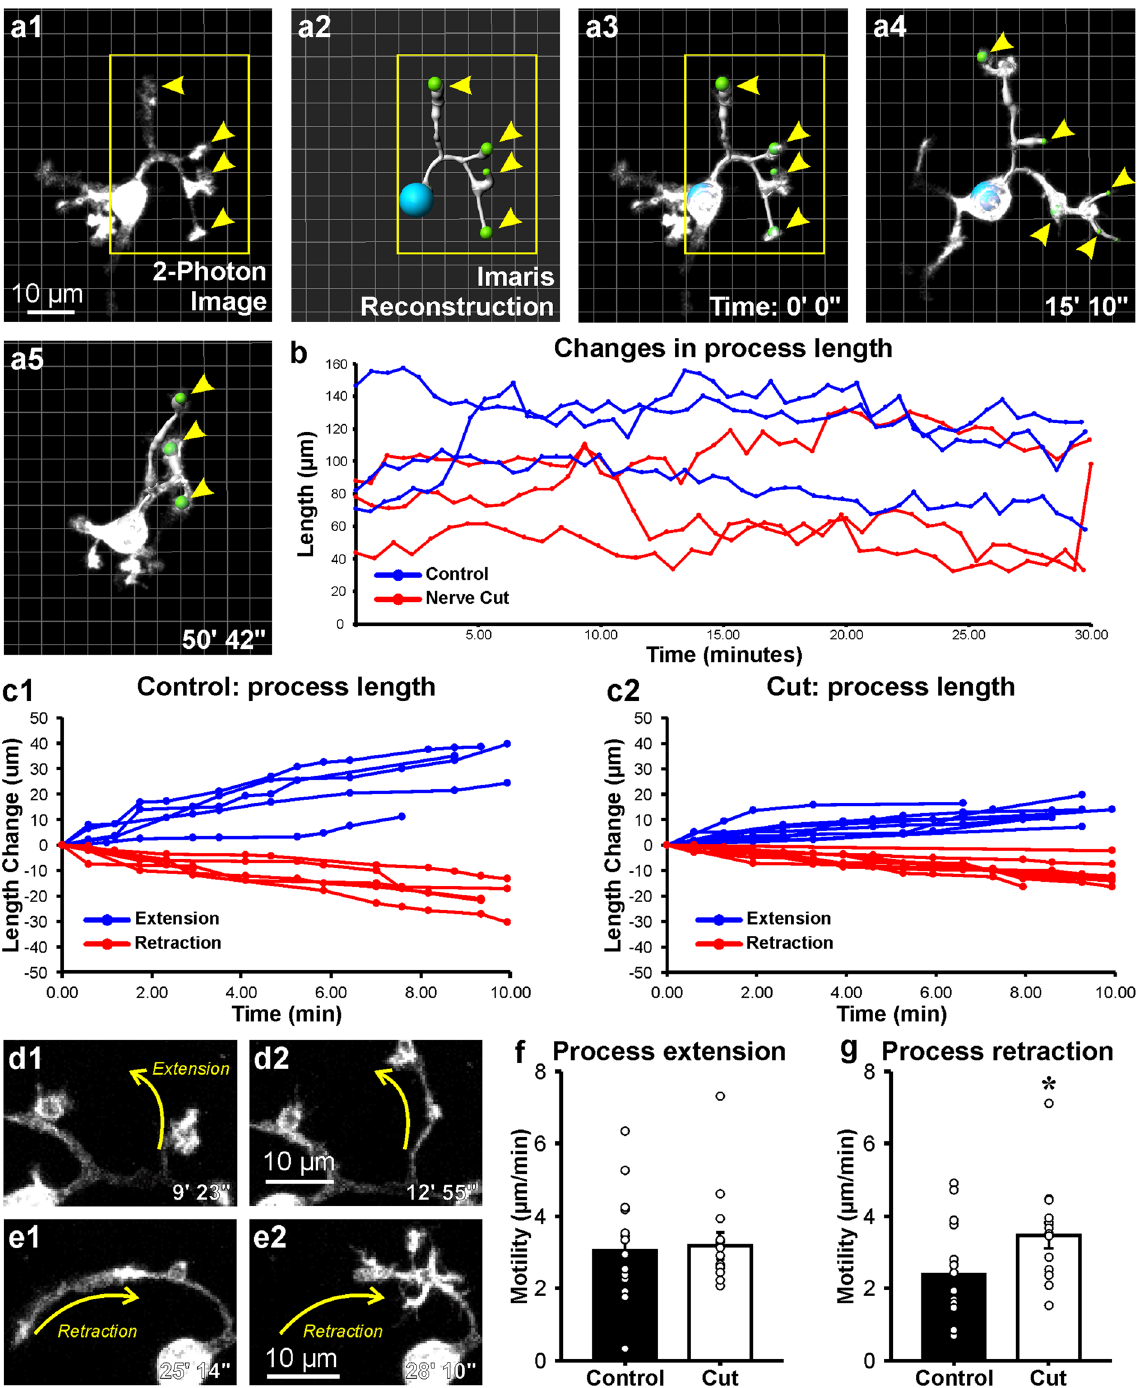
Figure 4. Individual microglia process motility. ( a1–5 ) Control microglia reconstructed using Imaris filament tracker. Single process reconstruction in ( a2 ). ( a3–a5 ) superimposition of process reconstruction and two- photon images over time. All process filaments can be followed in supplemental movie 5. Yellow arrowheads identify examples of terminal branches used to calculate terminal branch motilities. ( b ) Overall change in process total length over time in control microglia (blue lines) and microglia responding to a sciatic nerve cut 3 days after injury (red lines). Each line represents one cell and the total length of its processes over time. Total process lengths are larger in control microglia compared to microglia responding to nerve injury. Activated microglia have shorter processes. ( c1–2 ) Net change in extension (blue lines) and retraction (red lines) of individual processes from single control ( c1 ) and activated microglia ( c2 ). The changes in length represent total lengths and include the length of all branches in each process emanating from the cell body. The net change is greater in control for both extensions and retractions. ( d1–2, e1–2 ) An example of terminal branch extension ( d1–2 ) and retraction ( e1–2 ). ( f,g ) Motility of extensions and retractions for terminal microglia processes